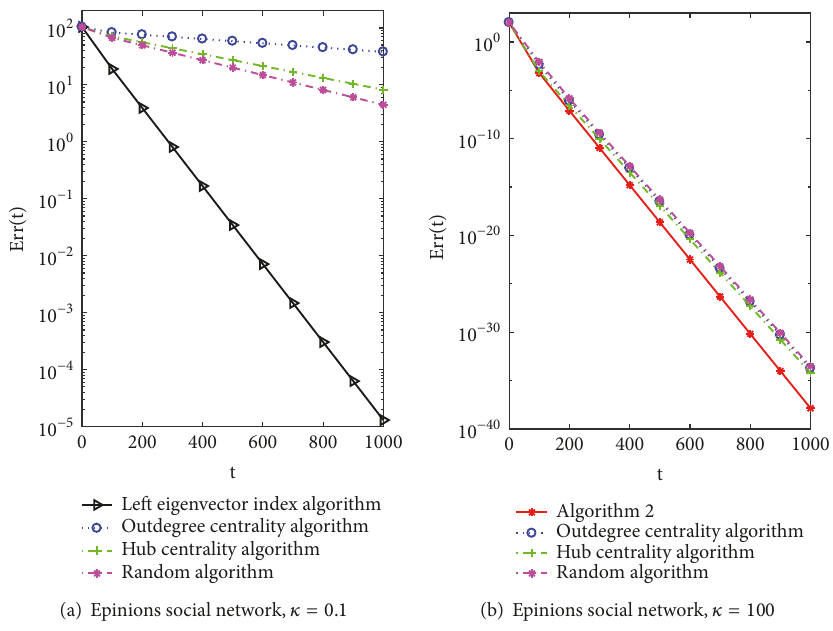
Figure 2: Dynamics of Err (𝑡) with different pinning algorithms. The pinned node number is 1000.